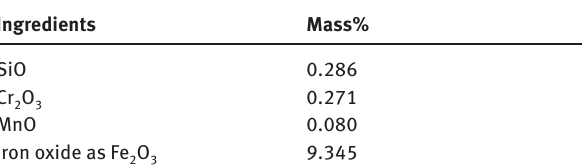
Table 2: Composition of fire side scale (mass%) Ingredients